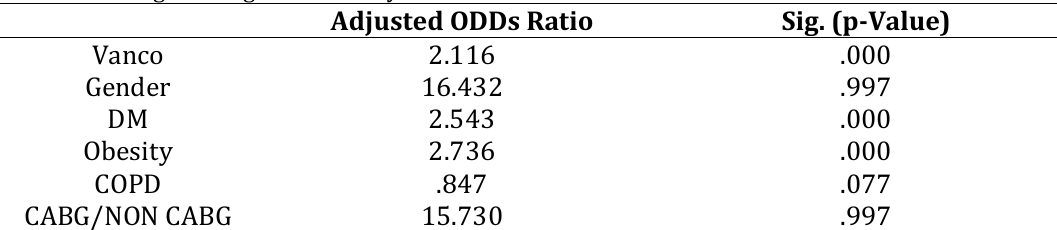
Table 2 : Logistic Regression Analysis Result